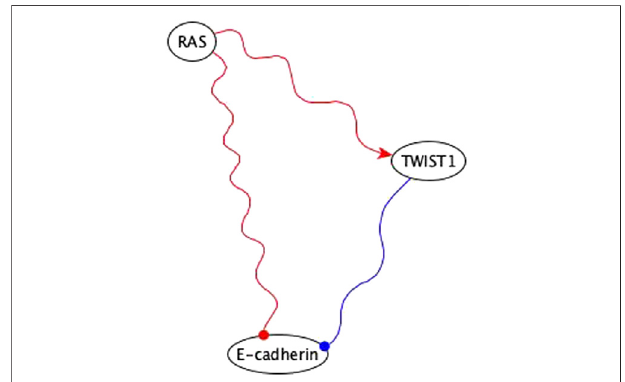
FIGURE 11 | Example of using co-pointing theorem for inference in the EMT network. RAS is suf fi cient inhibitory for E-cadherin via a subgraph and TWIST is a necessary inhibitory for E-cadherin. Suf fi cient inhibitory and necessary inhibitory logic implications are not compatible but since they share the same regulator, we can use the co-pointing theorem to conclude that RAS must be suf fi cient for TWIST1, which will result in the elimination of the edge from RAS to E-cadherin in the fi nal version of the